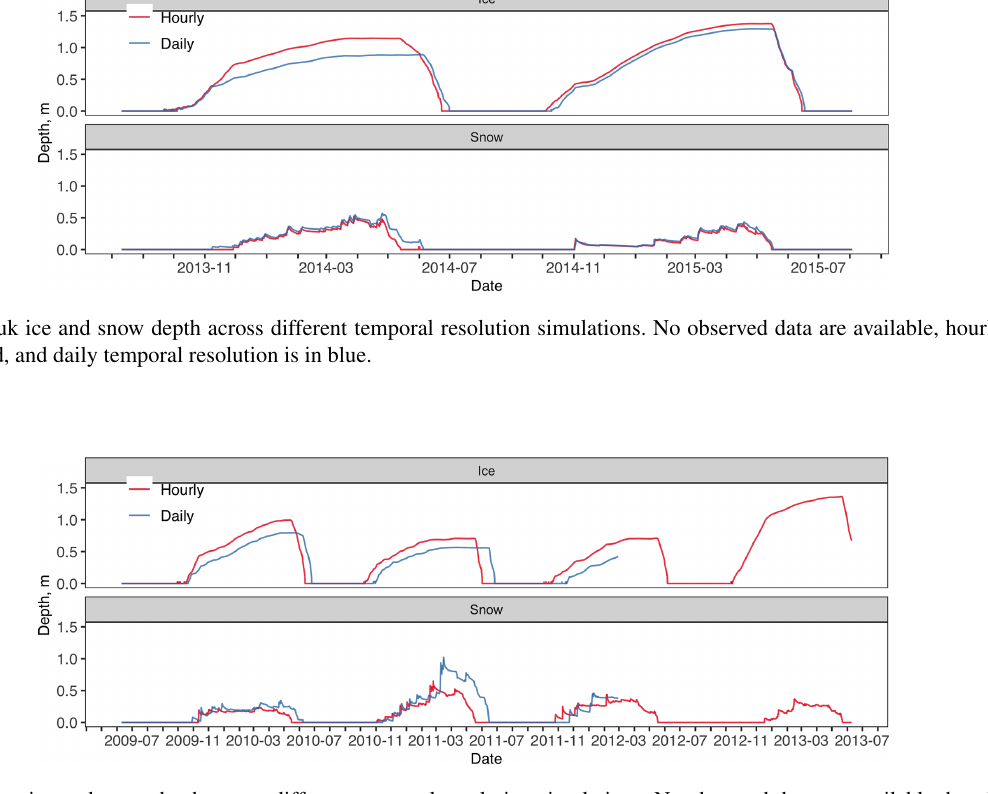
Figure F5. Fox Den ice and snow depth across different temporal resolution simulations. No observed data are available, hourly temporal resolution is in red, and daily temporal resolution is in blue.